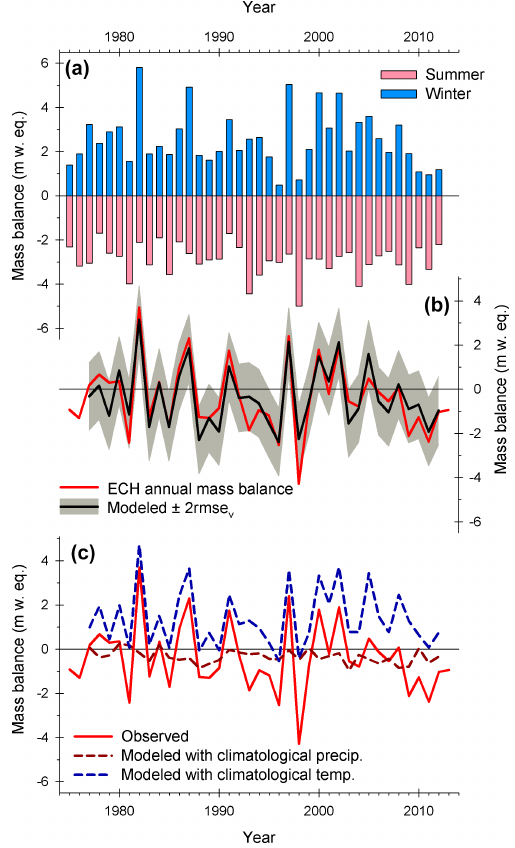
Figure 3. Panel (a) shows winter and summer values observed at ECH between 1975 and 2012. Panel (b) shows annual mass-balance series observed at ECH and modeled using El Yeso climate data (red and black lines). The estimated uncertainties of the modeled val- ues ( ± 2RMSE) are shown with gray shading. In panel (c) Annual mass balances observed at ECH (red line) are compared to mass bal- ances modeled using full variability in temperature but climatologi- cal monthly precipitation (dark-red dashed line), and full variability in precipitation but climatological monthly temperatures (dark-blue dashed line). Note the greater similarities between the observed se- ries and the precipitation-based mass-balance estimates.